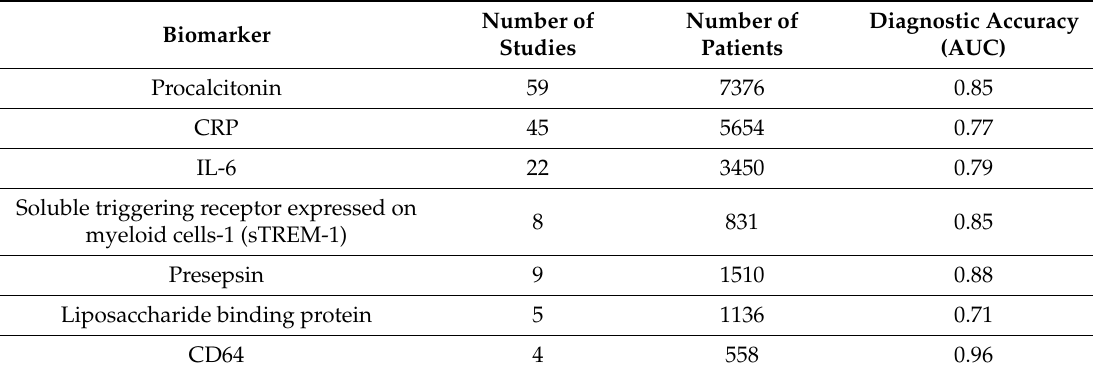
Table 5. Summary of most studied biomarkers identified by Liu and co-workers. The number of studies found, total number of patients from all studies for each biomarker, and the overall diagnostic accuracy (area under the curve, AUC) for each for the diagnosis of sepsis are shown. Adapted from Liu et al., 2016